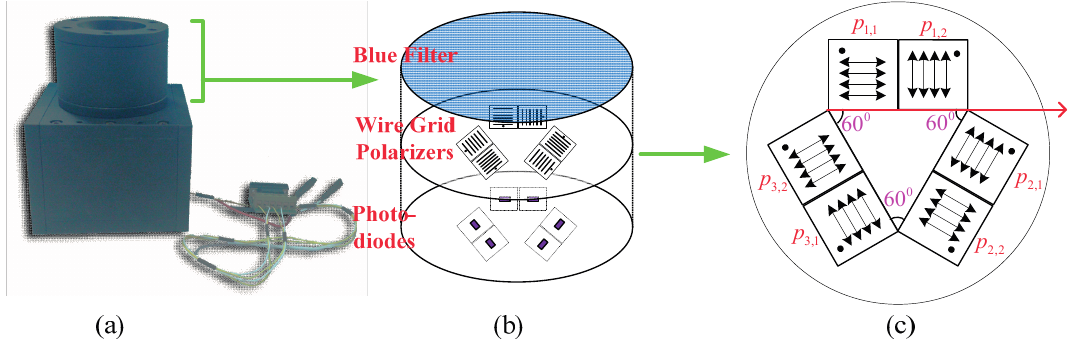
Figure 3. Schematic representation of the circuit signal